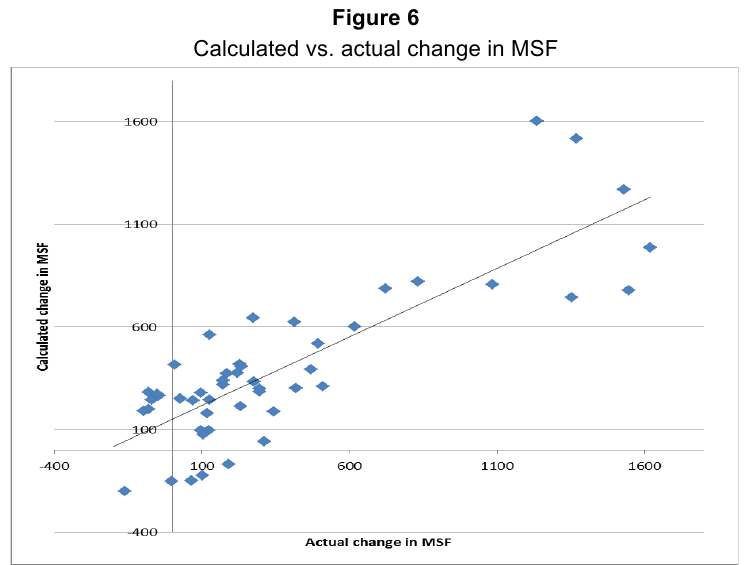
Calculated vs. actual change in